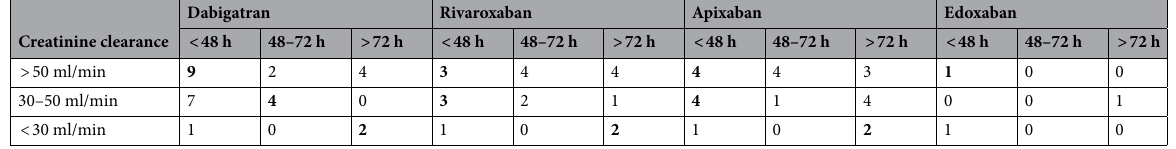
Table 5. Adherence to EHRA guidelines and PAUSE suggestions. Bold values indicate patients in whom surgery timing agreed to